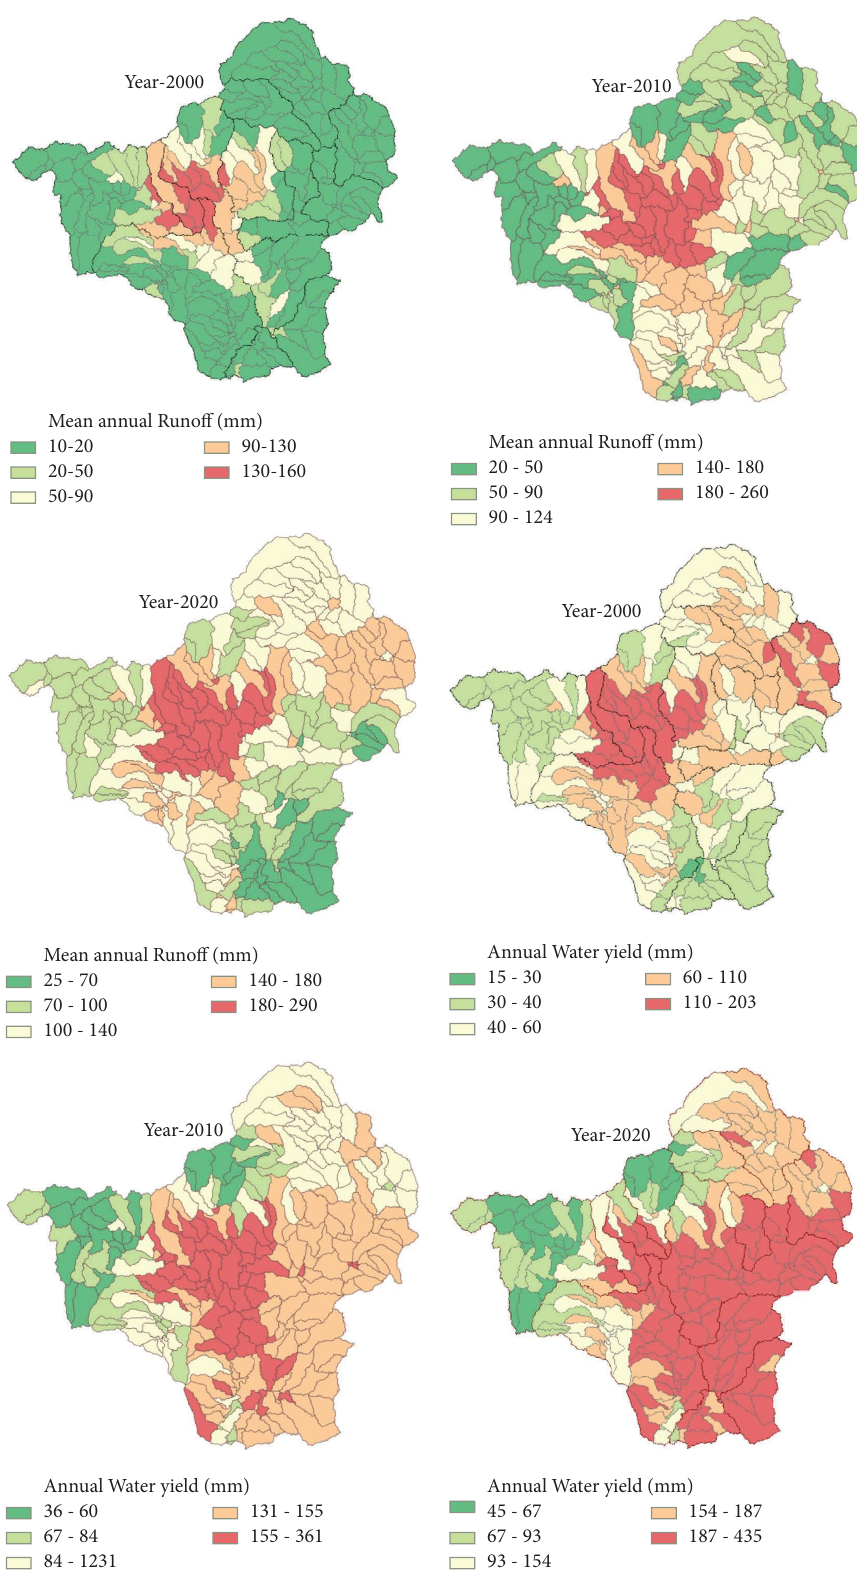
Figure 10: Spatial maps of potential runof and water yields at LSUs in the